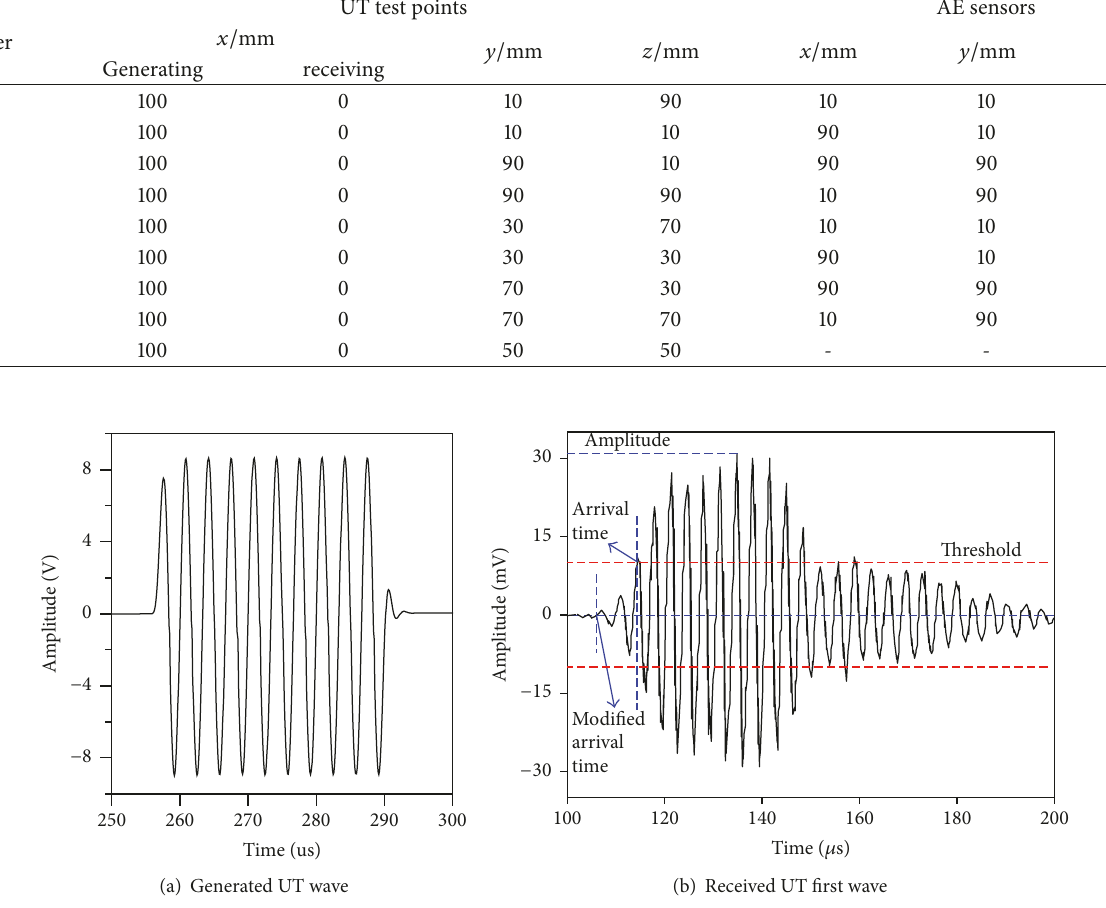
Figure 2: The generated UT wave and received UT first